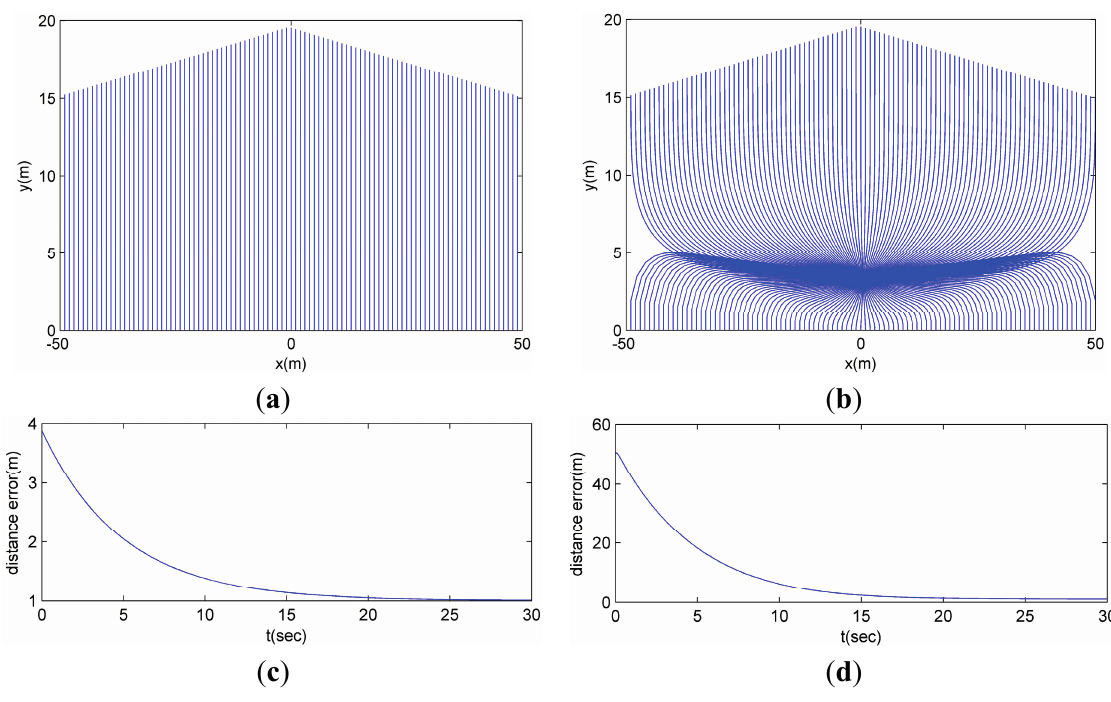
Figure 11. The contrast between the proposed MLC structure and CPA algorithm and the rigid formation. ( a ) The route of the robots employing the proposed MLC structure and CPA algorithm; ( b ) The route of the robots using the rigid formation; ( c ) The distance error of the robots with the proposed MLC structure and CPA algorithm; ( d ) The distance error of the robots using the rigid formation.